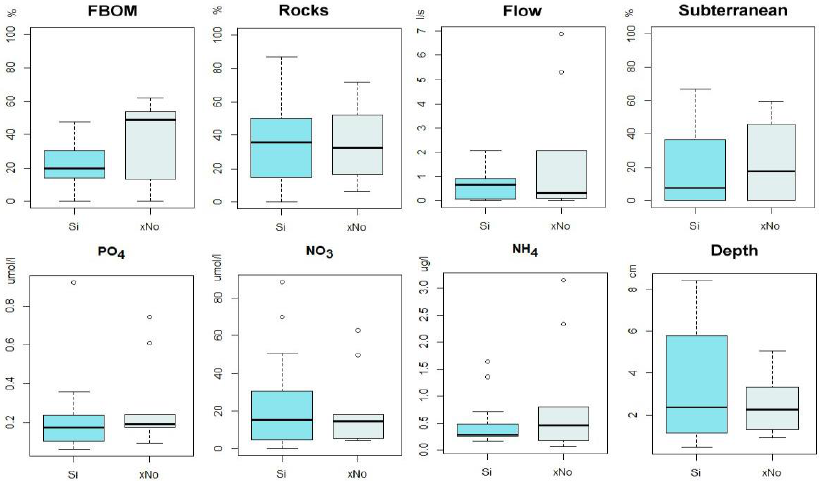
Figure 8. Some hydrolomorphological variables analyzed. FBOM: fine organic matter (expressed as percentage of the riverbed where this matter is found). Si: Streams with presence of newts. xNo: Streams with absence of newts. Depth: Average of Depth in the center of streambed. All comparisons are nonsignificant. Table 2. Chemical composition of the water in the streams inhabited by C. arnoldi and streams were C. arnoldi is absent. (Cond): Conductivity in µS/cm − 1 ; (Alc.): Alkalinity. Na + , K + , Ca 2 + , Mg 2 + , NH 4 + ,